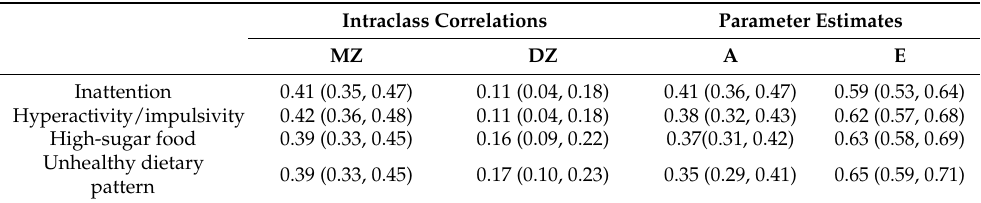
Table 2. Intra-class correlations and estimates from univariate twin models with 95% confidence intervals for ADHD trait dimensions and dietary